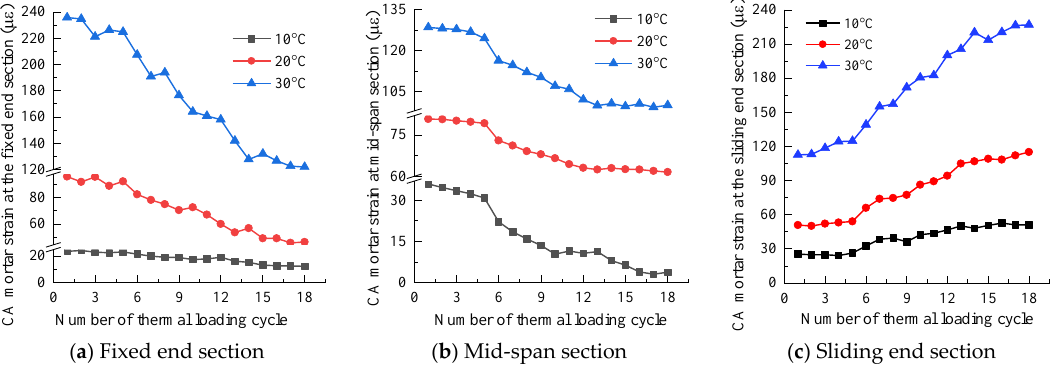
Figure 14. Variation of the CA mortar strain with the thermal loading cycles.